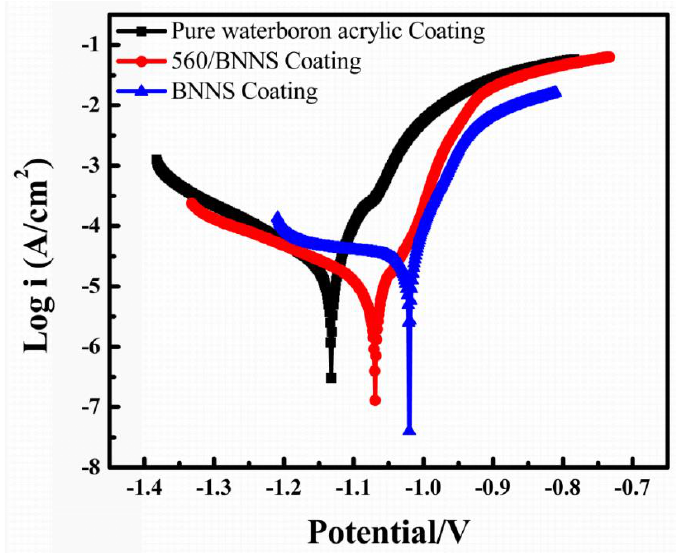
Figure 9. Potentiodynamic polarization curves of pure waterboron acrylic coating, BNNS coating and 560/BNNS coating. Table 1. Potentiodynamic polarization parameters and corrosion rate calculation results.